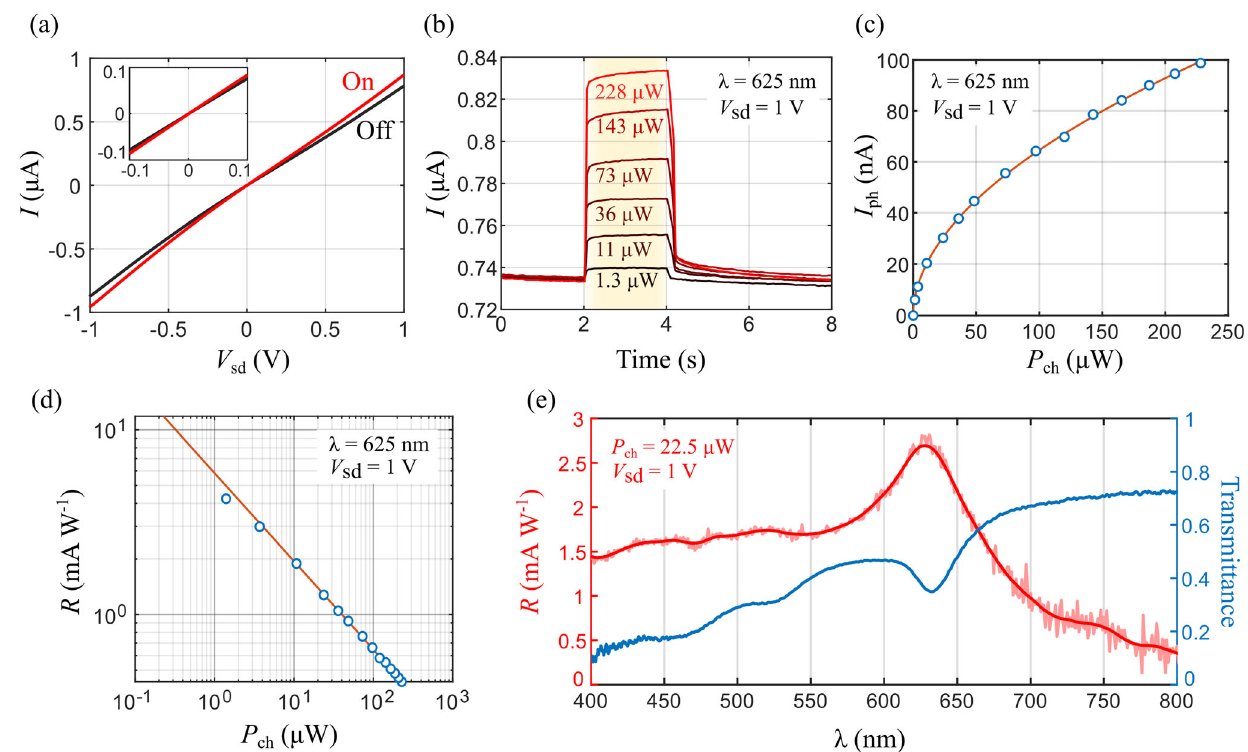
Fig. 3 Optoelectronic response of the devices. a IV characteristics of a WS 2 device, measured in the dark (black) and upon illumination (red) with wavelength λ = 625 nm and power P = 228 μ W (spot diameter 850 μ m). b Current vs . time measurements at V sd = 1 V, acquired while turning the illumination on (at t = 2 s) and off (at t = 4 s) for λ = 625 nm and increasing values of illumination power, from 1.3 to 228 μ W. The sample is kept in dark for 20 s after each measurement cycle to allow for stabilization. c Power dependence of the photocurrent, I PC , extracted from the on-off cycles shown in panel b as the difference between the current measured immediately before and one second after illumination is turned on. The orange line is a fi tting to a power law I PC ∝ P α , with α ≈ 0.5. d Device photoresponsivity as a function of